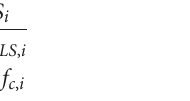
Frontiers in Earth Science |